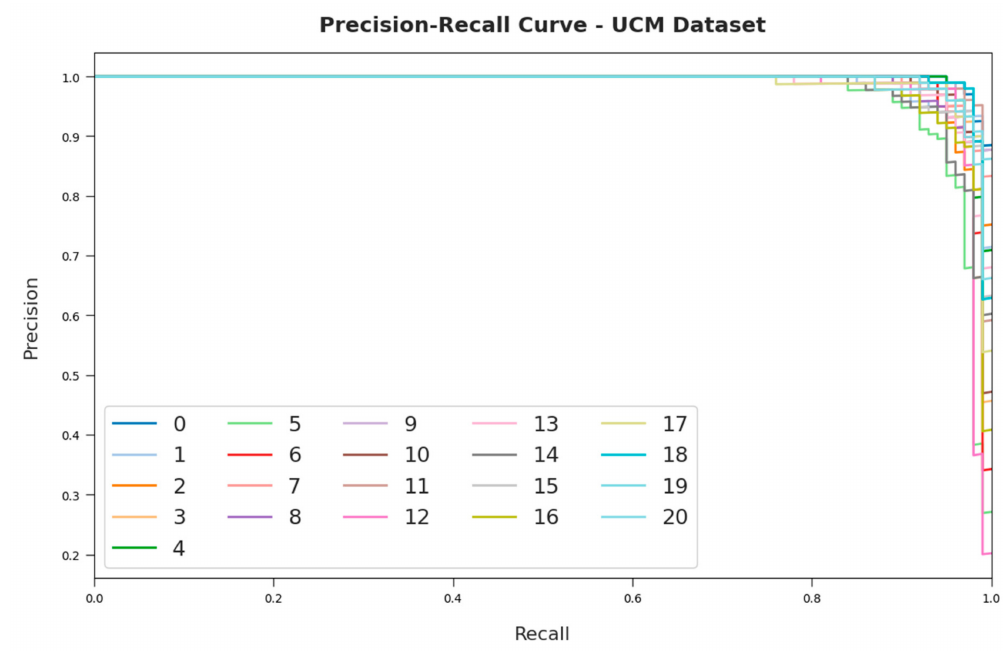
Figure 8. Precision-recall curve analysis of SIDTLD-AIC technique on UCM